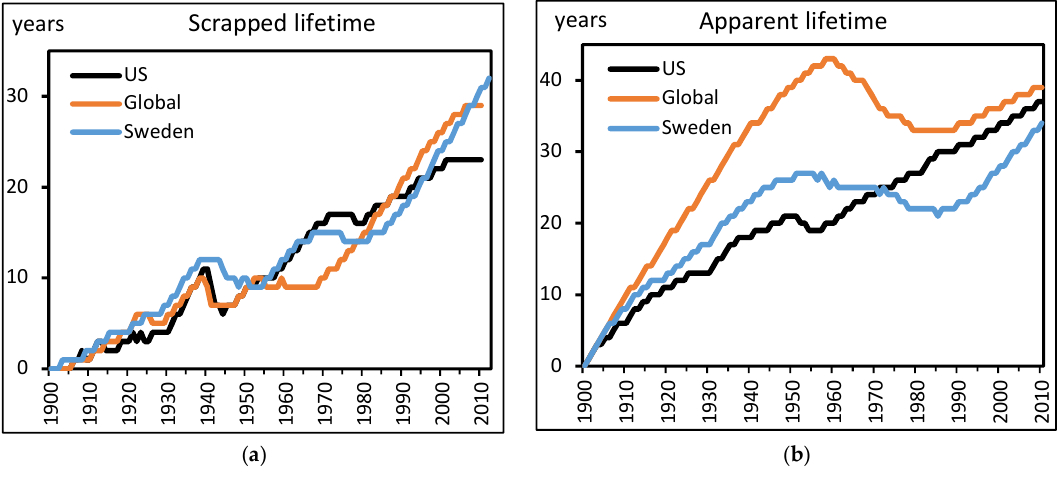
Figure 7. Steel lifetimes (total for all sectors) in the U.S., Sweden and the world, calculated with the VCM for 1900 to 2010: ( a ) scrapped lifetime; ( b ) apparent lifetime.